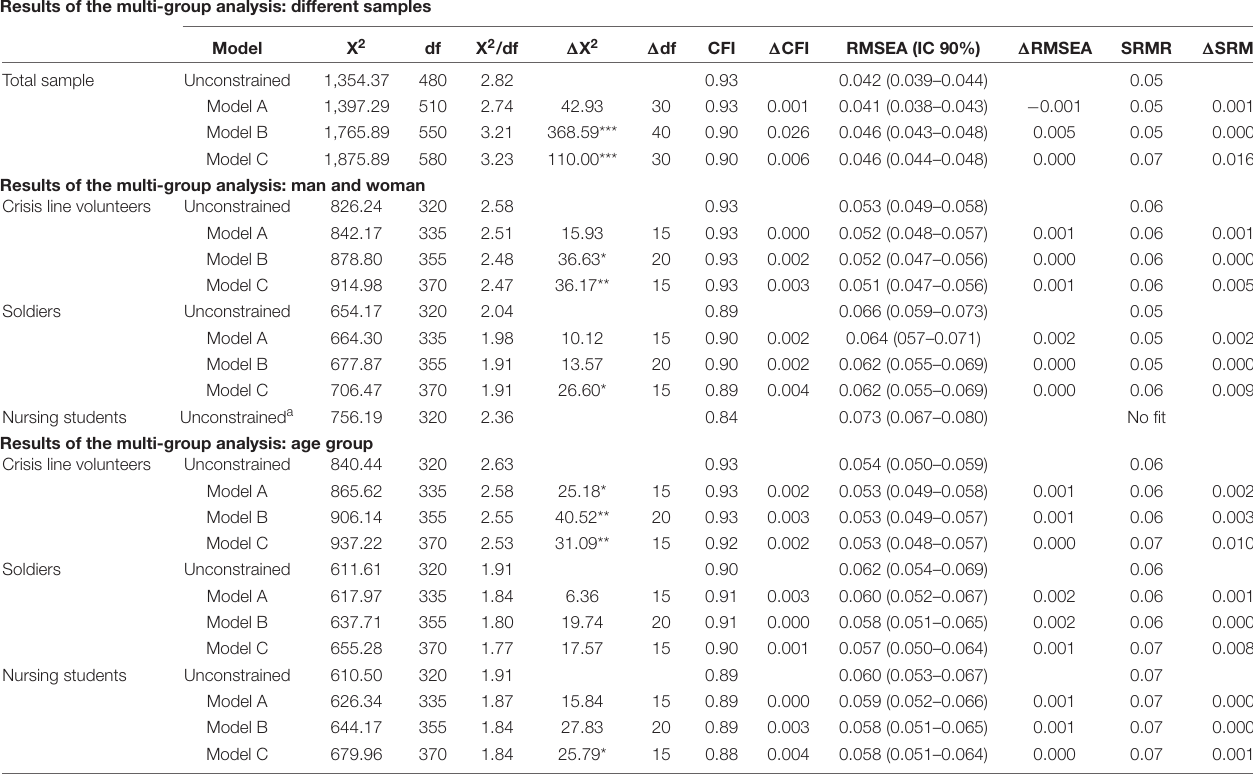
TABLE 5 | Three multi-group analyses of the five-factor model in: the different samples, gender, and age. Results of the multi-group analysis: different